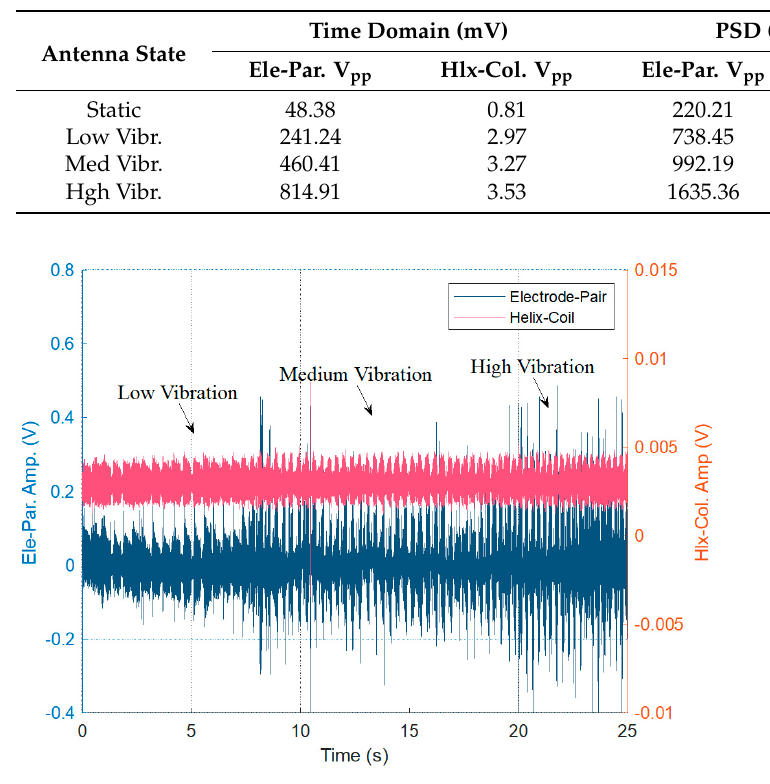
Figure 8. Signals received in the time domain under various vibrations. Table 2. Experimental results of signal and noise varying with various vibrations.